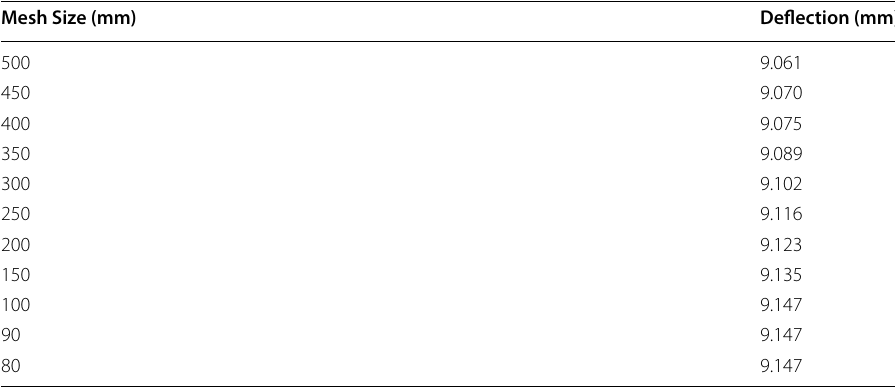
Table 2 Convergence